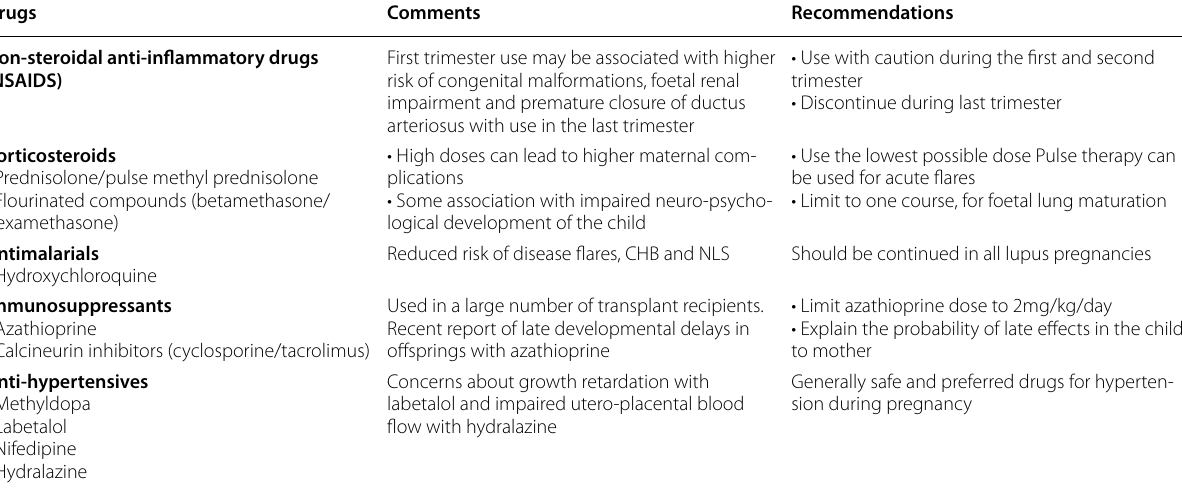
SLE systemic lupus erythematosus, LN lupus nephritis, aPL anti-phospholipid antibodies, NLS neonatal lupus syndromes, CHB congenital heart block, NSAIDS non- steroidal anti-inflammatory drugs